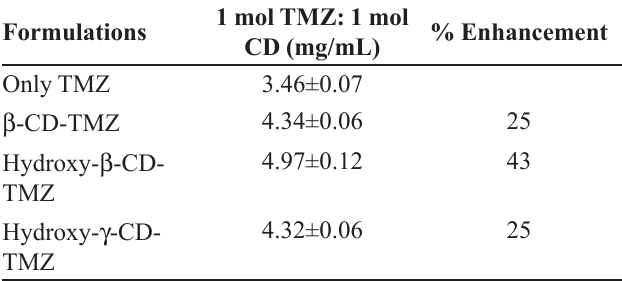
TABLE I - Amount of solubilized TMZ in mg/mL in 0.1 M HCl after the formation of inclusion complex after 24 hours Formulations